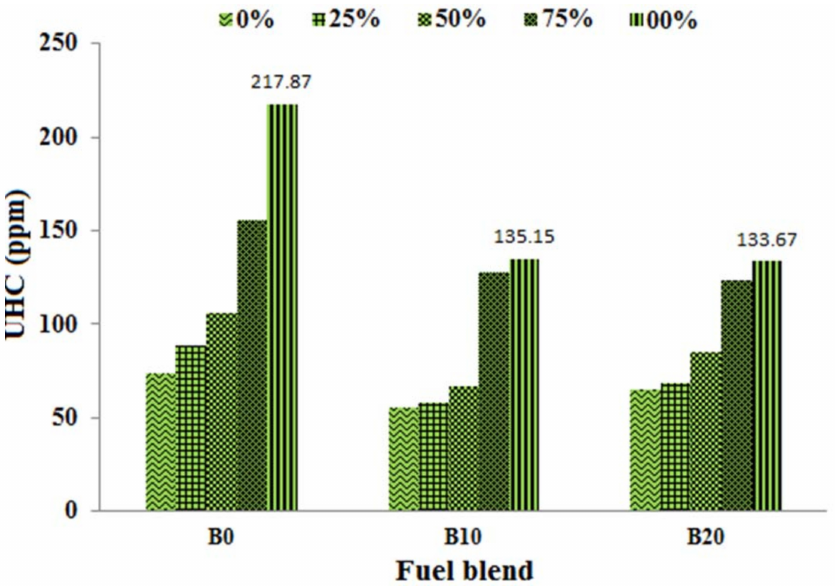
Figure 9. Results of unburned hydrocarbons (UHC) for different fuel blends at the constant speed of 2100